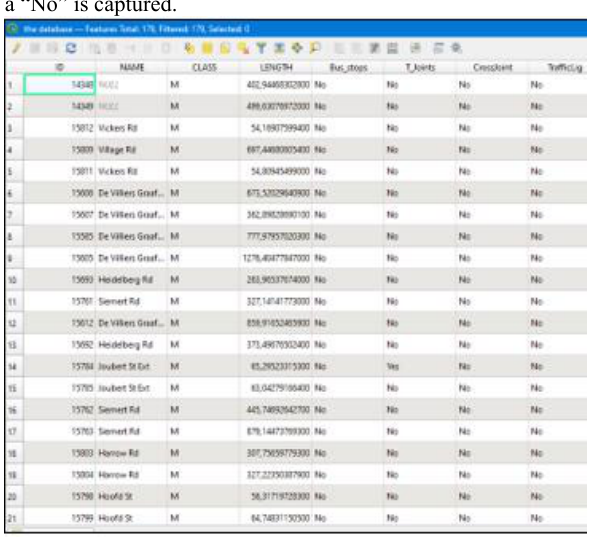
Figure 4 . The attribute table of the segmented road feature class.